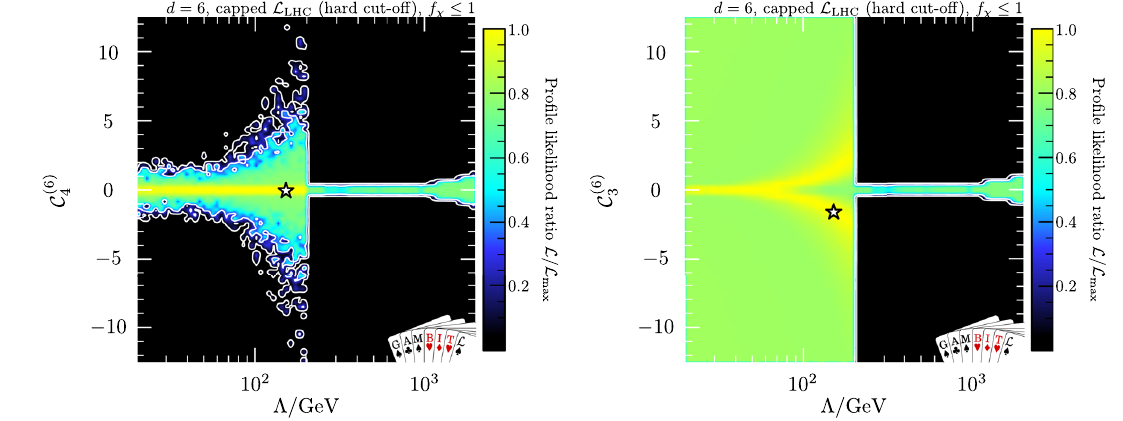
( 6 ) plane (left) and the (cid:2) – C 2 σ confidenceregions.Notethatthepositionofthebest-fitpoints(white 4 3 stars) in the two panels is somewhat arbitrary, as there is a degeneracy ( 6 ) between (cid:2) and C and hence the likelihood is essentially constant 3 , 4 across the entire yellow region